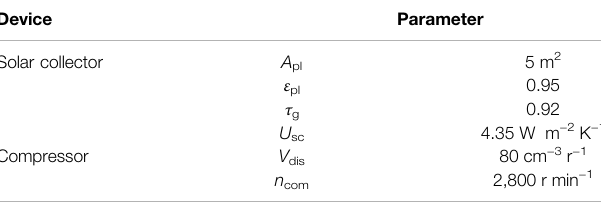
TABLE 3 | Thermophysical parameters of R410A, R407C, R134a, and R1234yf.